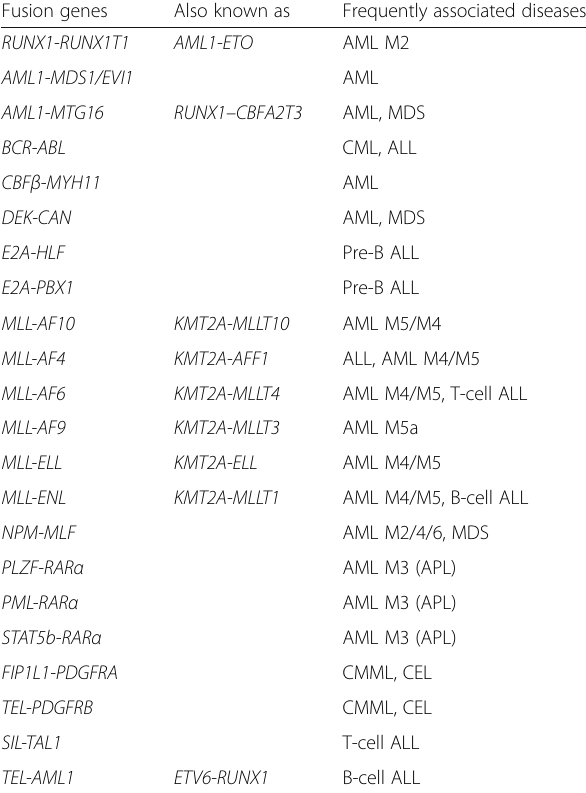
Table 2 22 fusion genes screened using the multi-fusion gene F-qRT-PCR assay system